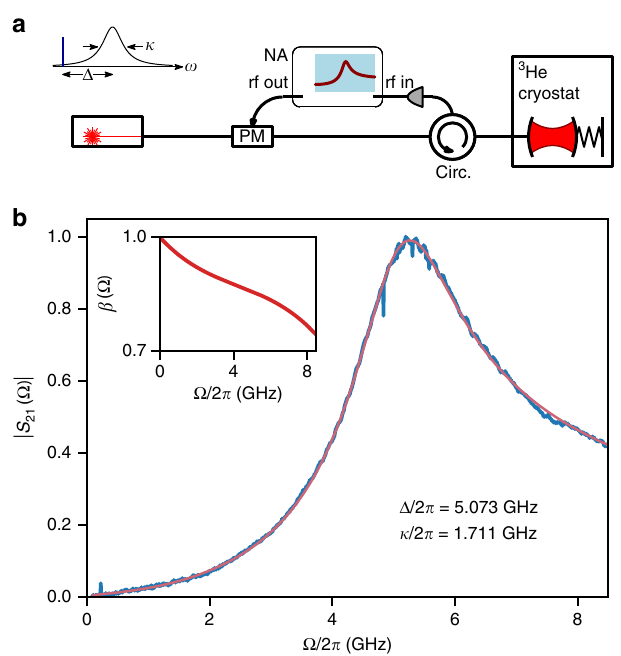
Fig. 6 Coherent response determination of detuning and